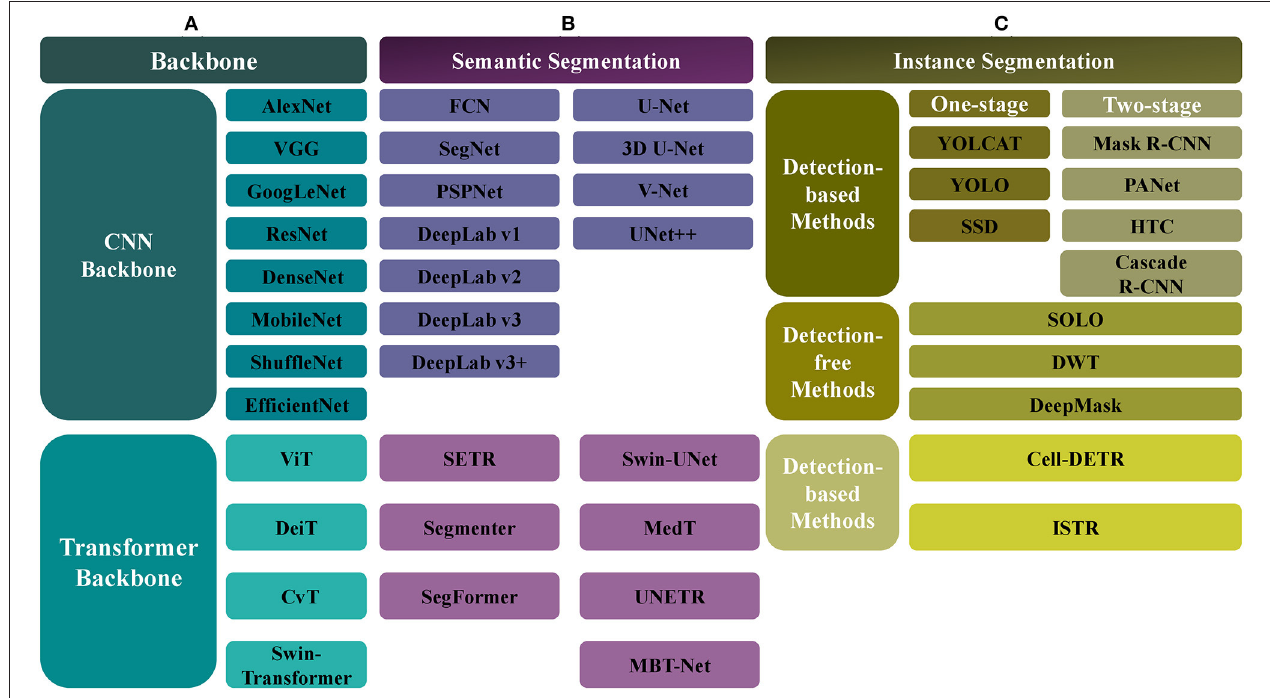
FIGURE 2 | The overview of automatic segmentation algorithms. (A) For the backbone network, there are CNN-based and Transformer-based methods, the former includes AlexNet, VGG, GoogLeNet, ResNet, DenseNet, MobileNet, ShuffleNet, and EfficientNet, and the latter includes ViT, Data-efficient image Transformers (DeiT), Convolutional vision Transformer (CvT), and Swin-Transformer. (B) For the semantic segmentation, the CNN-based methods include FCN, SegNet, PSPNet, DeepLab (v1, v2, v3, v3 + ), UNet, VNet, and UNet ++ , and the Transformer-based methods include SETR, Segmenter, SegFormer, Swin-UNet, Medical Transformer (MedT), UNETR, MBT-Net, TransUNet, and TransFuse. (C) The instance segmentation task also can be categorized into CNN-based and Transformer-based methods. Meanwhile, it can be divided into the detection-based and the detection-free instance segmentation methods, the former is divided into the single-stage (YOLCAT,